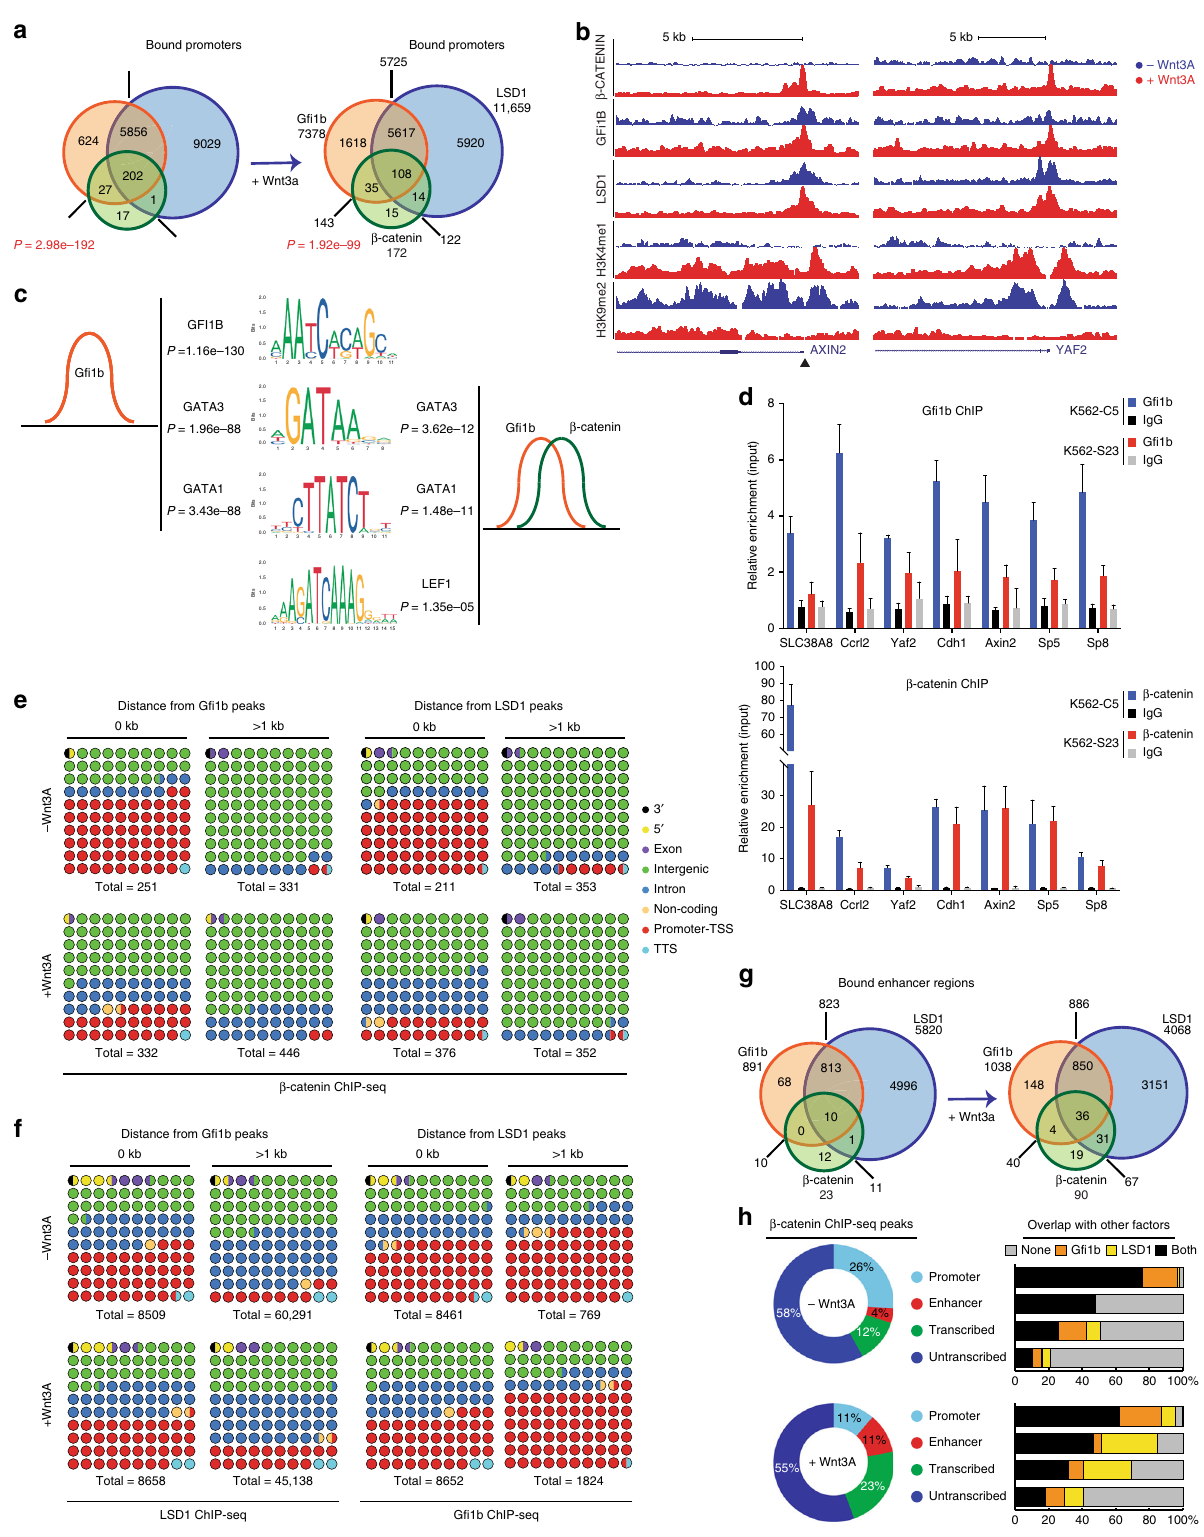
WT MKs with Wnt3A led to a RI decrease and higher Wnt3A concentration treated WT MKs resemble untreated G fi 1b KO MKs (Fig. 9d and Supplementary Fig. 8c). This data suggest that G fi 1b is required to maintain a level of Wnt/ β -catenin activity necessary to control HSC and MK cellularity and the response of MKs to integrin. NATURE COMMUNICATIONS| (2019) 10:1270